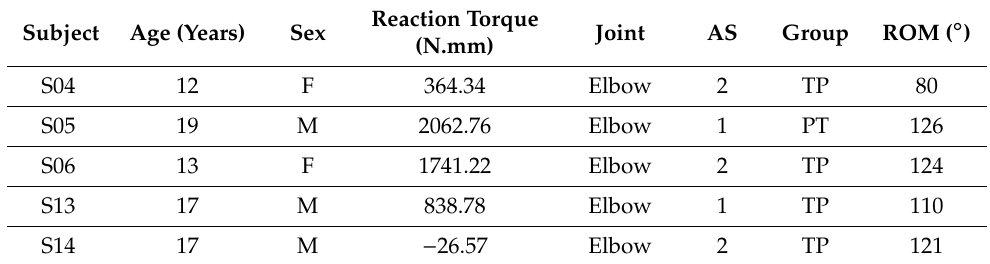
Table 2. Information of some patients enrolled for the clinical study and the parameters taken into account in prescribing pseudoelastic hinges [33].